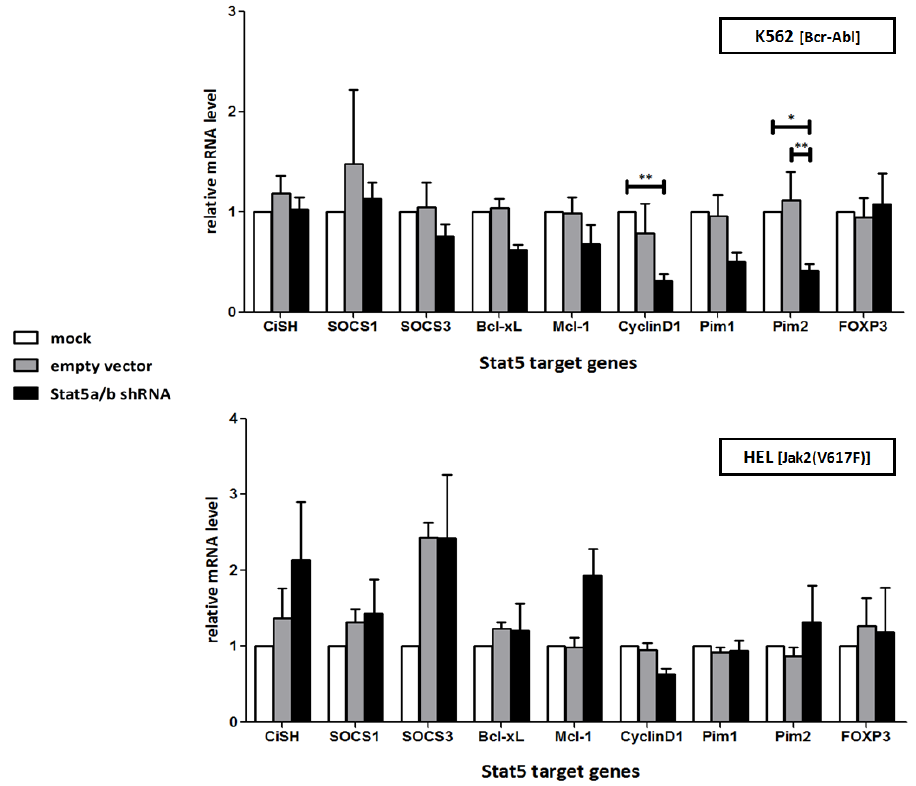
Figure 3. Stat5 specific shRNA reduces the expression of Stat5 target genes Bcl-xL, Cyclin D1 and Pim2 in Bcr-Abl + K562, but not in Jak2(V617F) + HEL cells. Relative expression level of selected Stat5 target genes were analyzed by qRT-PCR in lentivirus transduced K562 and HEL cells. The cells were lysed after seven days and total RNA was extracted for qRT-PCR measurement. Data were normalized to HPRT1 housekeeping gene expression and the relative levels are shown as folds of mock treated control cells ( n = 3; Ø ± SD). Significantly reduced gene expression level of shRNA expressing cells in comparison to mock and empty vector expressing control cells are indicated. * p < 0.05, ** p < 0.01 (2-way-ANOVA with Bonferroni